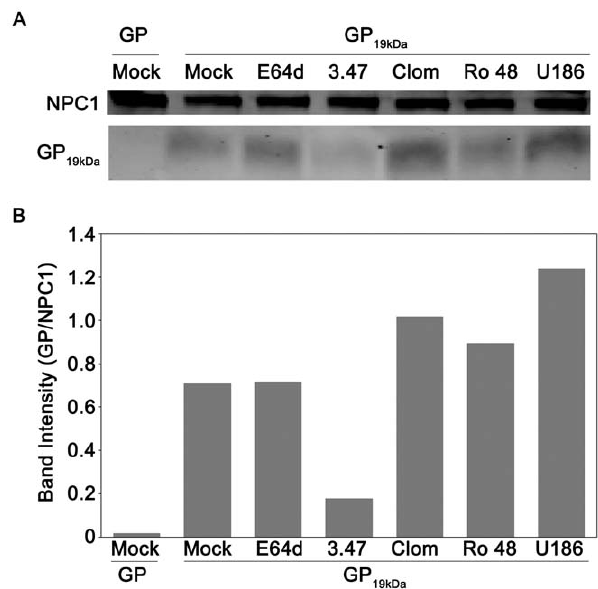
Figure 7. CADs do not disrupt the interaction of 19 kDa GP and NPC1. (A) NPC1-FLAG-enriched LE/Lys membranes from CHO NPC1 cells were disrupted and then incubated with inhibitors for 30 min at RT: mock (4% DMSO), E64d (10 m M), compound 3.47 (13 m M), clomiphene (242 m M), Ro 48-8071 (174 m M), and U18666A (800 m M); each inhibitor was used at a concentration 100 fold over its IC 50 for inhibition of infection. The samples were then incubated with 3 m g uncleaved (GP) or cleaved (GP 19 kDa ) EBOV GP ectodomains for 1 hr at RT. Samples were then lysed, and incubated overnight with anti-FLAG beads. Bound NPC1 and GP were then eluted from beads, and run on an SDS-PAGE gel. The gel was then transferred, blotted for both NPC1 and EBOV GP, and imaged for fluorescent signal. As predicted, uncleaved GP ( , 130 kDa) did not co-precipitate with NPC1 [20,24]. (B) The intensities of the GP, GP 19 kDa , and NPC1 bands from each sample of the blot shown in Fig. 7A were quantified and GP or GP 19 kDa was normalized to its respective NPC1 band signal. The experiment was conducted four times with similar results, and a representative experiment is